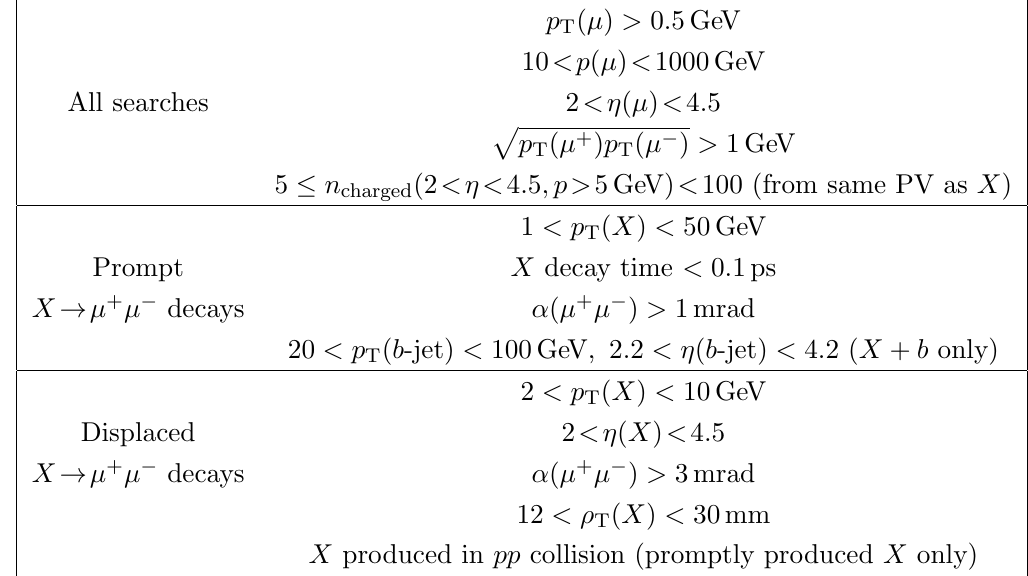
Table 1 . Fiducial regions of the searches for prompt and displaced X